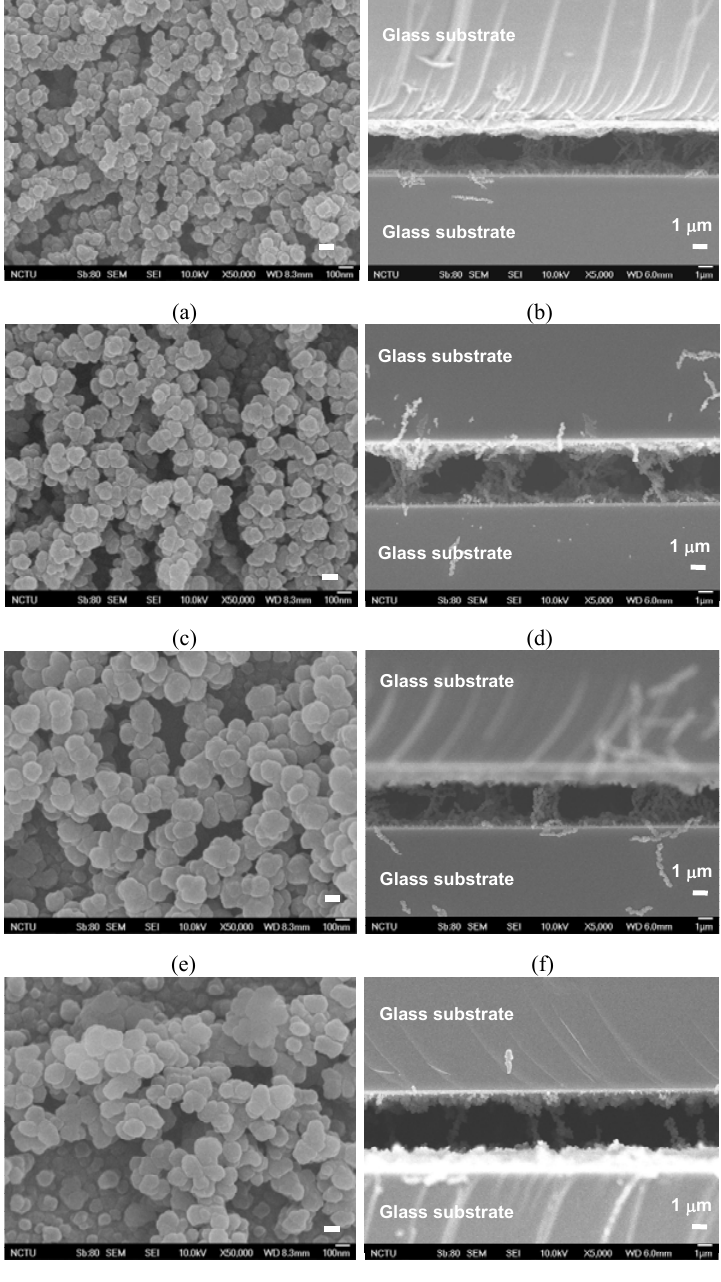
Figure 5. SEM photographs of dye-doped LC gels at curing temperatures 10 °C (a, b), 20 °C (c, d), 30 °C (e, f), and 40 °C (g, h). The LC and dye were extracted. (a), (c), (e) and (g) are the top views of the cells. (b), (d), (f), and (h) are the side views of the cells. The white-indicated bars in (a), (c), (e) and (g) are 100